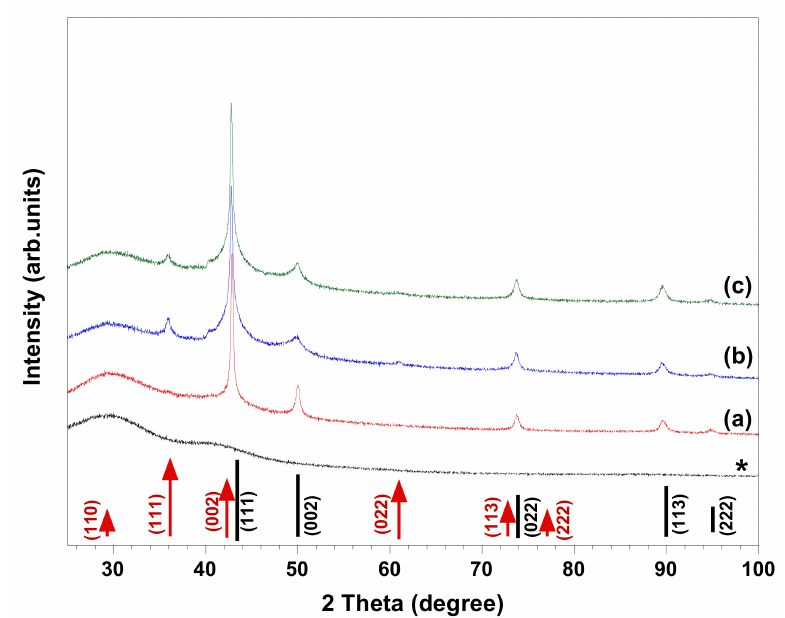
Figure 2. XRD patterns of materials obtained in 0.01 M Cu(II) solutions containing ( a ) 0.01 M EDTA, ( b ) 0.01 M DTPA, and ( c ) 0.01 M C 12 -DTPA. The positions of the expected Bragg peaks from copper (black lines), and cuprous oxide (red arrows) are marked and labeled with their respective Miller indices. The diffraction pattern denoted by * in the plot stems from the type RA Millipore membrane filter used to separate synthesized material by simple vacuum